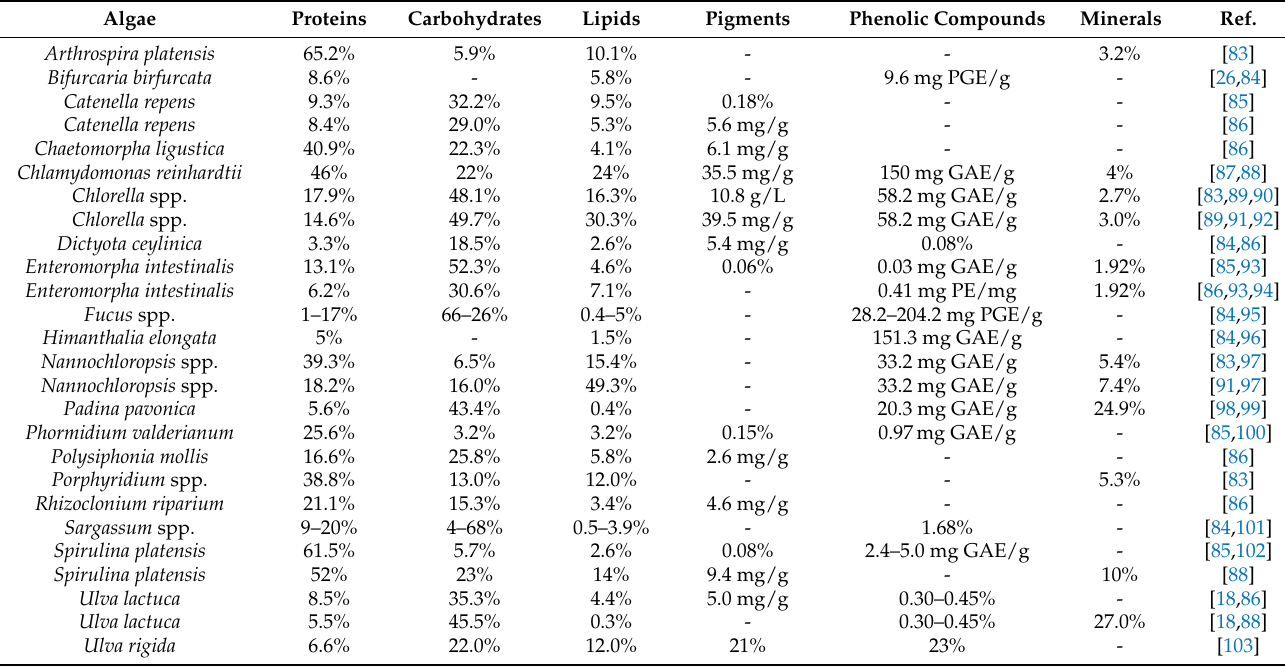
Table 2. Composition of several marine algae